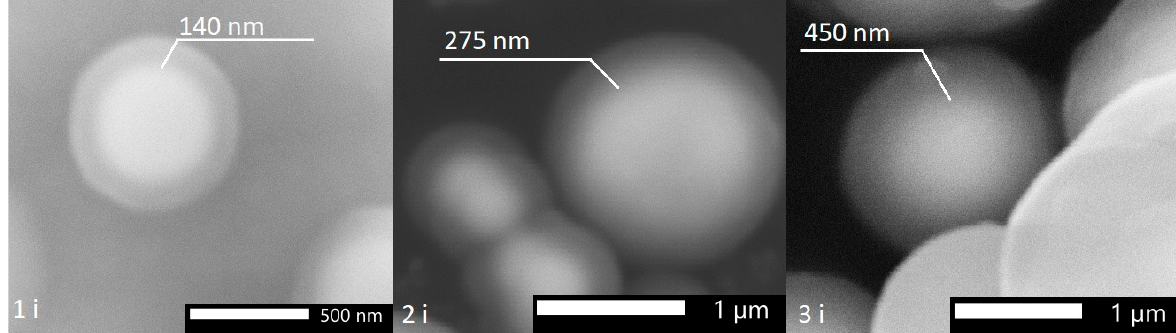
Figure 2. SEM images of Fe-SiO 2 particles with a different number of iterations. Table 1. SiO 2 shell thicknesses vs. the number of iterations of SiO 2 deposition on iron particles. Number of Iterations